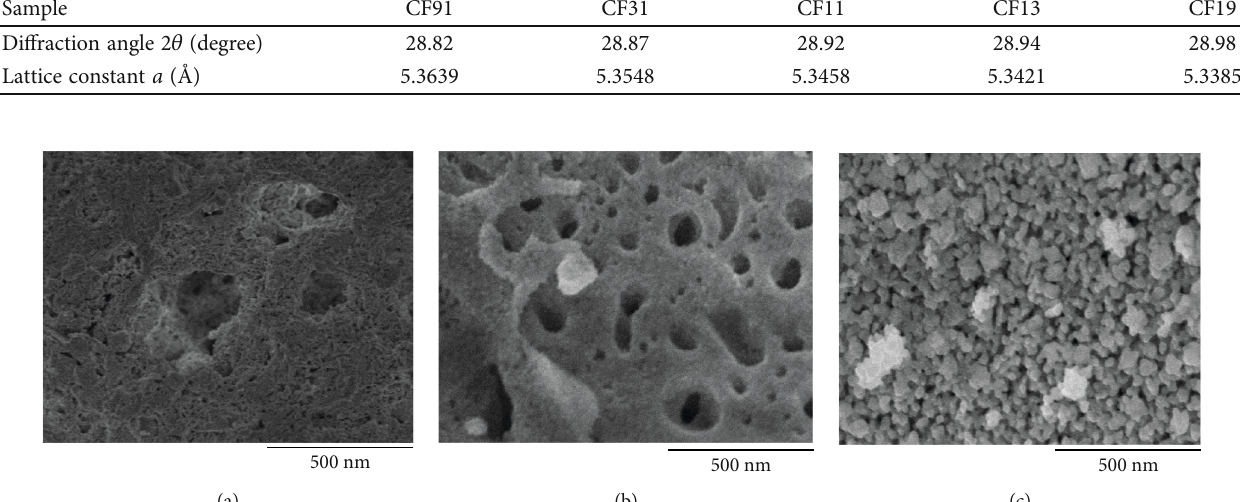
Table 2: 2 θ di ff raction angle and a lattice constant of CeO Sample CF91 CF31 CF11 CF13